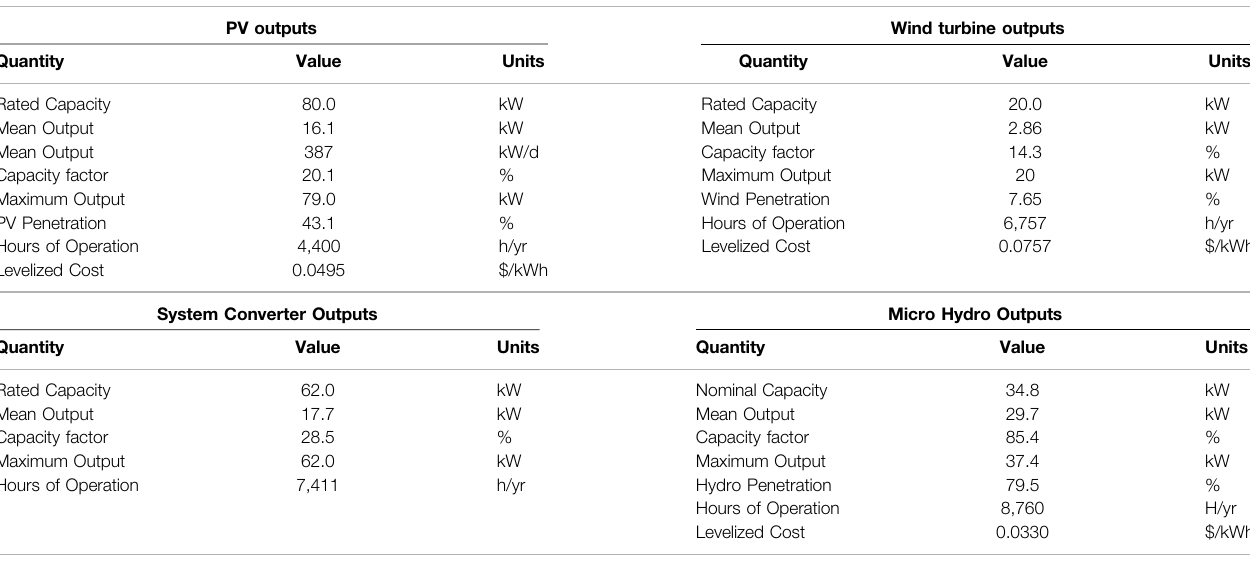
TABLE 6 | PV, Wind turbine, Micro-hydro, and system converter outputs of HRES.